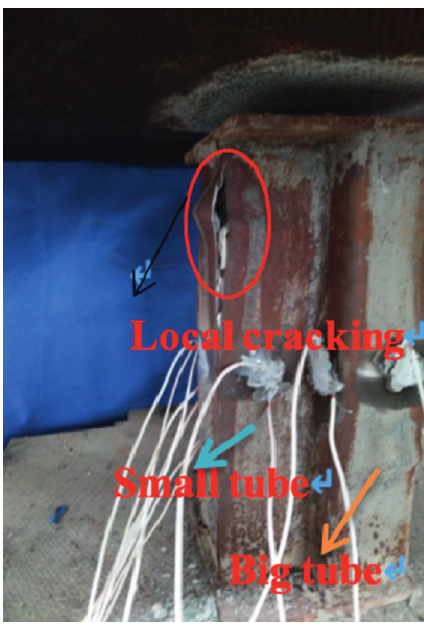
Figure 10: Local